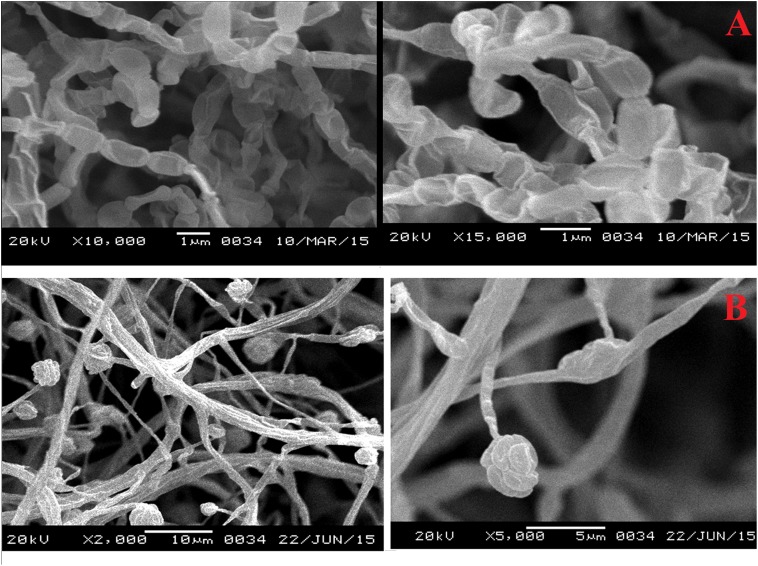
Field emission gun-scanning electron microscopy (FEG-SEM) micrographs of (A) Streptomyces sp. (BPSAC34) and (B) Leifsonia xyli (BPSAC24) showing spore chain morphology.